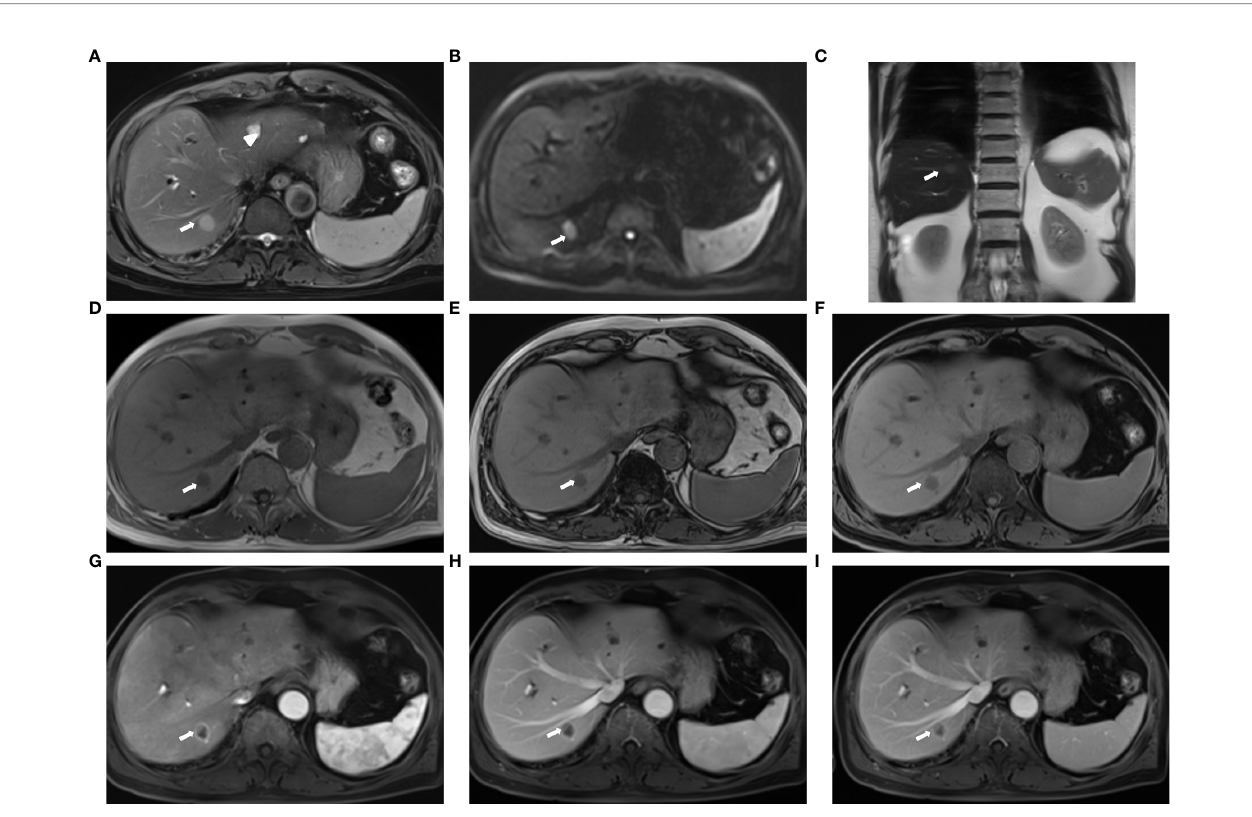
FIGURE 2 | Sample images acquired with the fast liver work fl ow of a 74-year-old man with liver metastasis (primary: colon cancer): (A) T2-weighted BLADE; (B) DWI, b = 1000 s/mm 2 ; (C) T2-HASTE; (D, E) in-phase and out-of-phase DIXON VIBE; (F) water images of DIXON VIBE; (G – I) contrast-enhanced T1WI VIBE with arterial-phase (G) , venous-phase (H) , and delayed-phase (I) . The metastasis (arrow) in liver segment VII appeared as slightly high signal intensity on the T2 BLADE and T2 haste image, whereas the hepatic cysts [arrowhead in (A) ] in liver segments II and IV show high signal intensity in T2 BLADE. The metastasis is hyperintense in DWI and has low intensity in T1WI. Annular enhancement is visible in the enhanced MR imaging relative to the surrounding liver